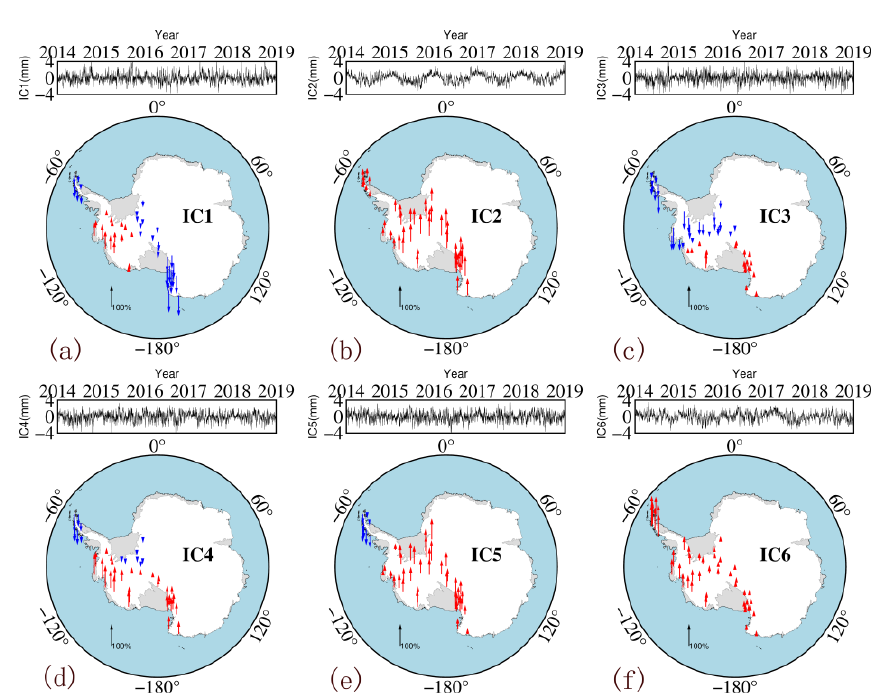
Figure 6. Six independent components (IC) of independent component analysis (ICA) solution. From ( a) to ( f) are IC1, IC2, IC3, IC4, IC5 and IC6, respectively. (The time series at the top of each panel shows the IC of each component; the maps at the bottom show the normalized spatial responses (red: positive response; blue: negative response)).